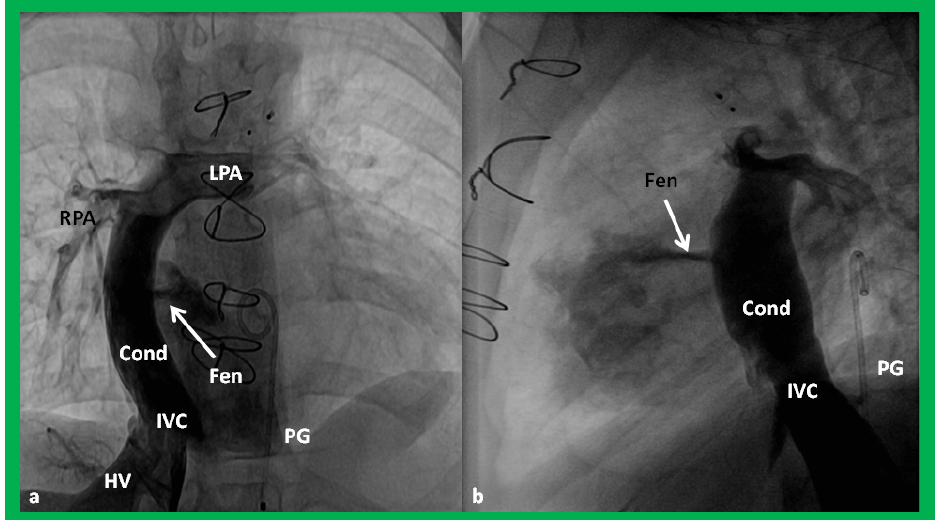
Figure 54. Selected cine frames in postero–anterior ( a ) and lateral ( b ) views, demonstrating Stage IIIA Fontan procedure diverting the inferior vena caval (IVC) flow into the pulmonary arteries via a nonvalve conduit (Cond). Flow across the fenestration (Fen) is shown by arrows in ( a , b ). HV, hepatic veins; LPA, left pulmonary artery; PG, pigtail catheter in the descending aorta; RPA, right pulmonary artery. Modified from Rao PS, Indian J Pediatr , 2015; 82:1147-56 [36].